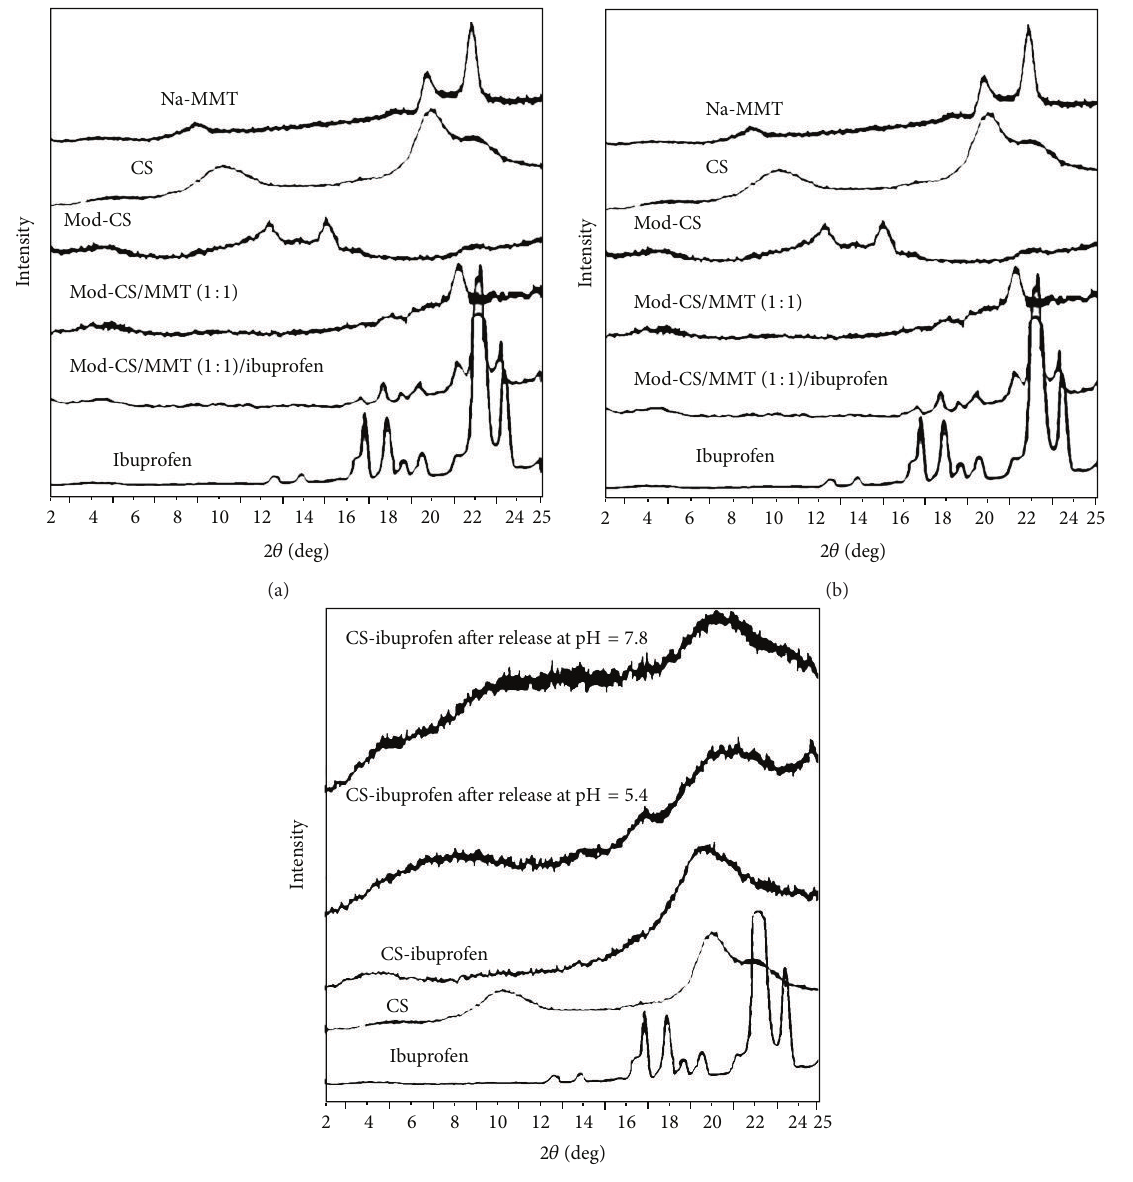
Figure1:X-raydiffractionpatternof(a)Na-MMT,CS,mod-CS,mod-CS/MMT(1:1),ibuprofen,mod-CS/MMT—ibuprofenoncold.(b)Na- MMT,CS,mod-CS,andmod-CS/MMT(1:1),ibuprofen,mod-CS/MMT—ibuprofenonhot.(c)Ibuprofen,CS,andCS/ibuprofenafterrelease at pH = 5.4 and